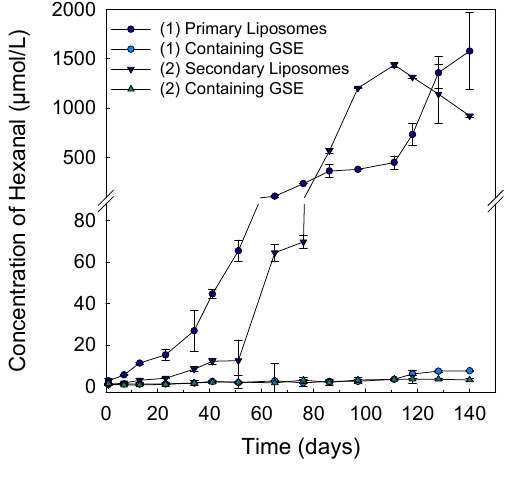
Figure 4. Concentration of hexanal in primary (1) and secondary liposomes (2) with or without encapsulated GSE during a time period of 140 days in the dark at 25